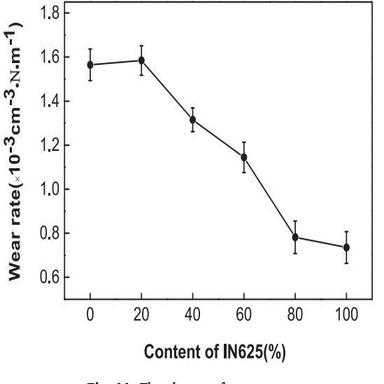
The change of wear rate.